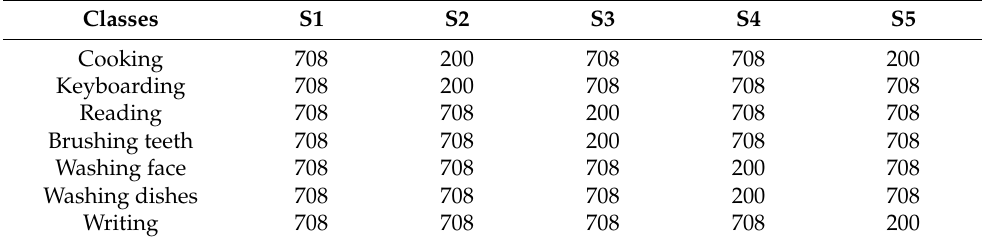
Table 6. Classes